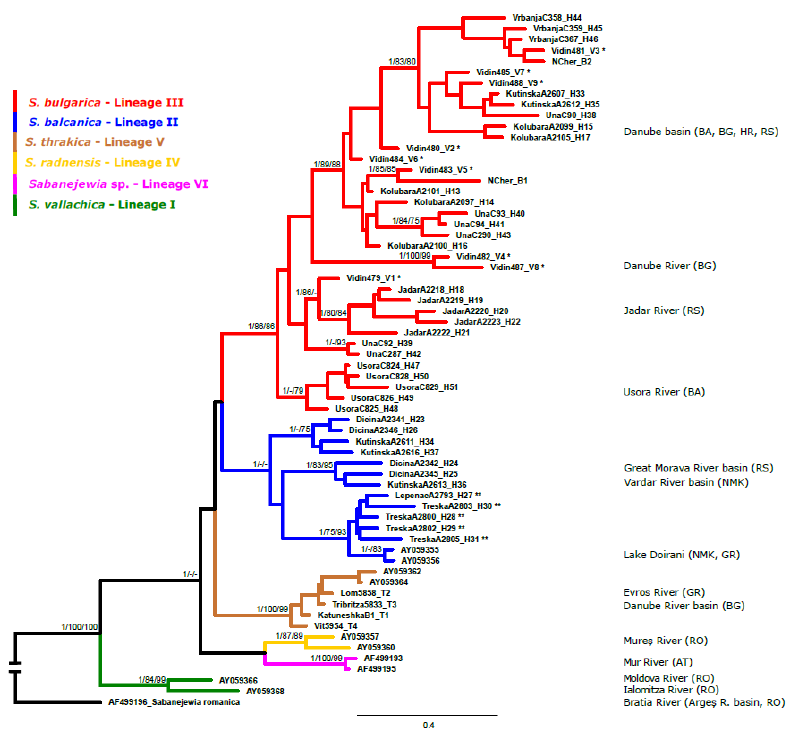
Figure 5. Bayesian consensus tree of Sabanejewia DB complex haplotypes resulting from the analysis of cyt b sequence data. Bayesian posterior probabilities and ML/NJ bootstrap values are listed above the branches (only value 1 for BI and ≥ 75% for ML and NJ are shown). The letters in brackets indicate the international country codes, terr. typ. indicates type locality. The tip labels are river names and haplotypes or the GenBank accession number (letter H – from [17]; letters AF, AY – from [13], letters V from [15] letters B, T – our samples; see Table S1) * S. bulgarica type locality, ** S. balcanica type locality.